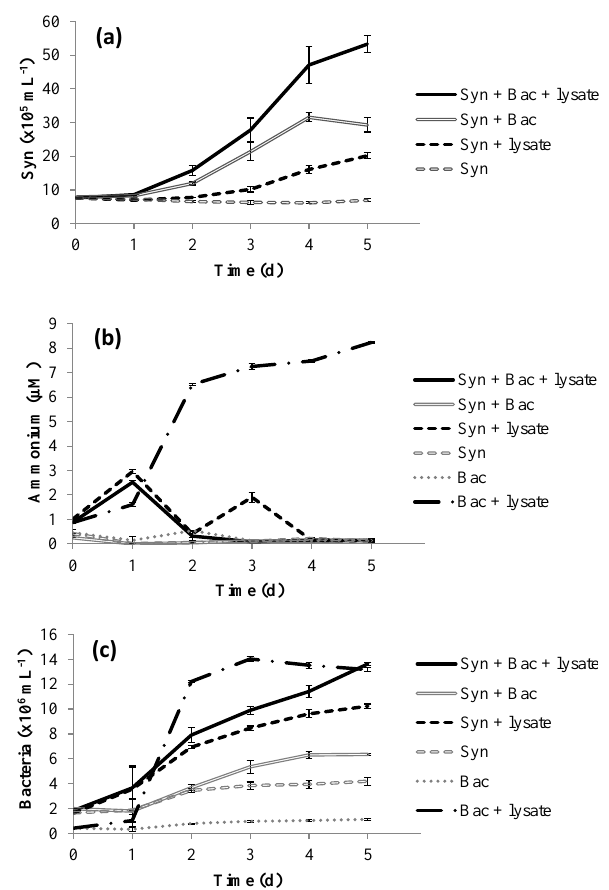
Figure 1. Time series of (a) Synechococcus abundance, (b) ammo- nium concentration, and (c) bacterial abundance in the laboratory experiment. Error bars are standard error from triplicate incuba-